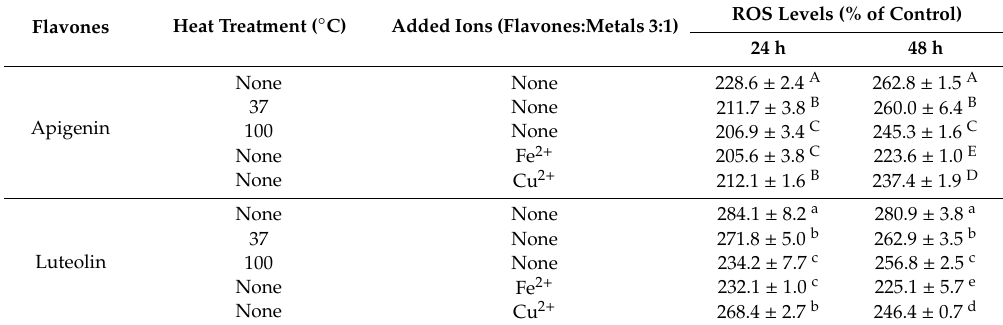
Table 2. The measured reactive oxygen species (ROS) levels in the Hela cells treated with di ff erent samples for 24 and 48